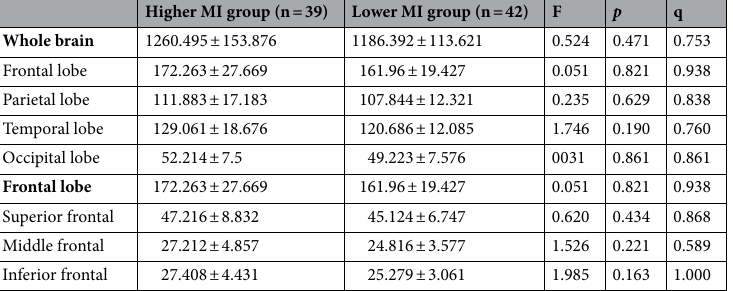
Higher MI group (n = 39) Lower MI group (n = 42)